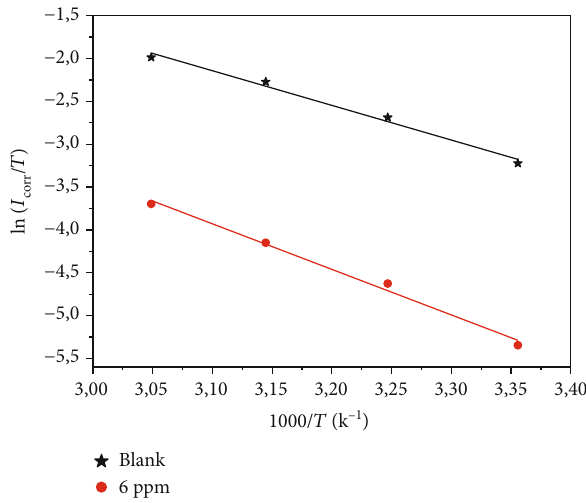
/ T ) as a function corr